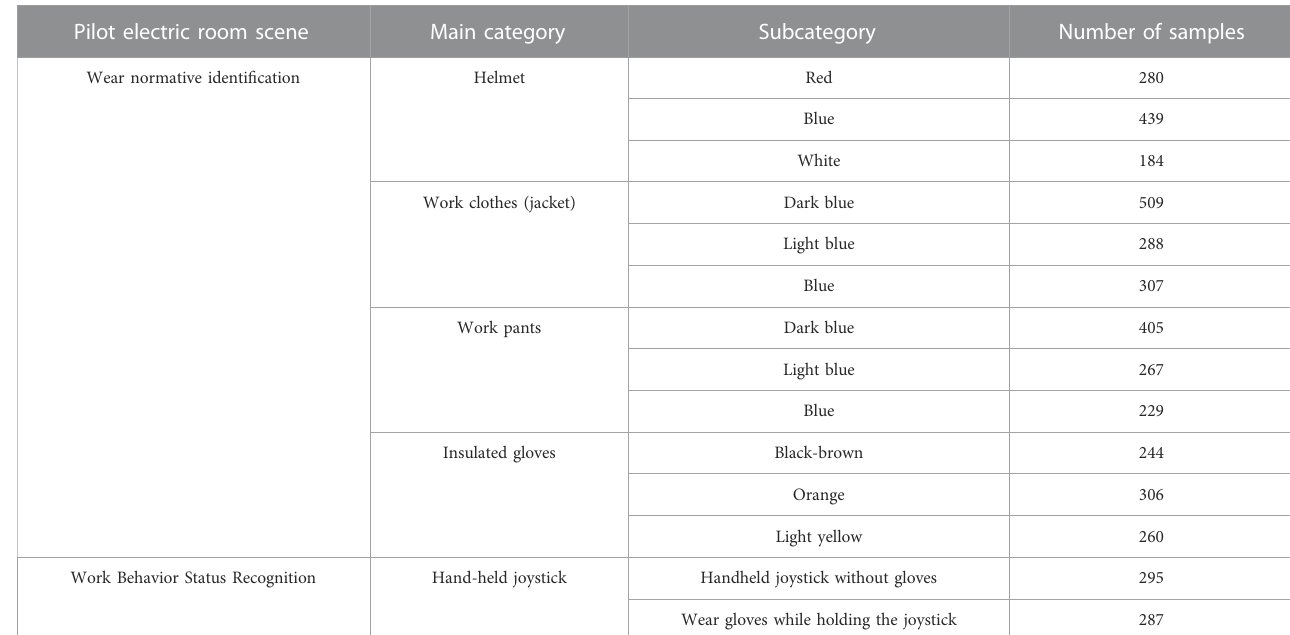
TABLE 1 Annotation of training